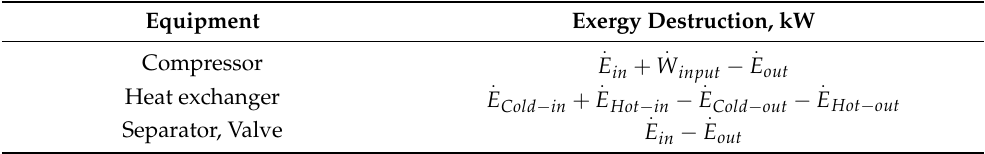
Table 9. Equation of exergy